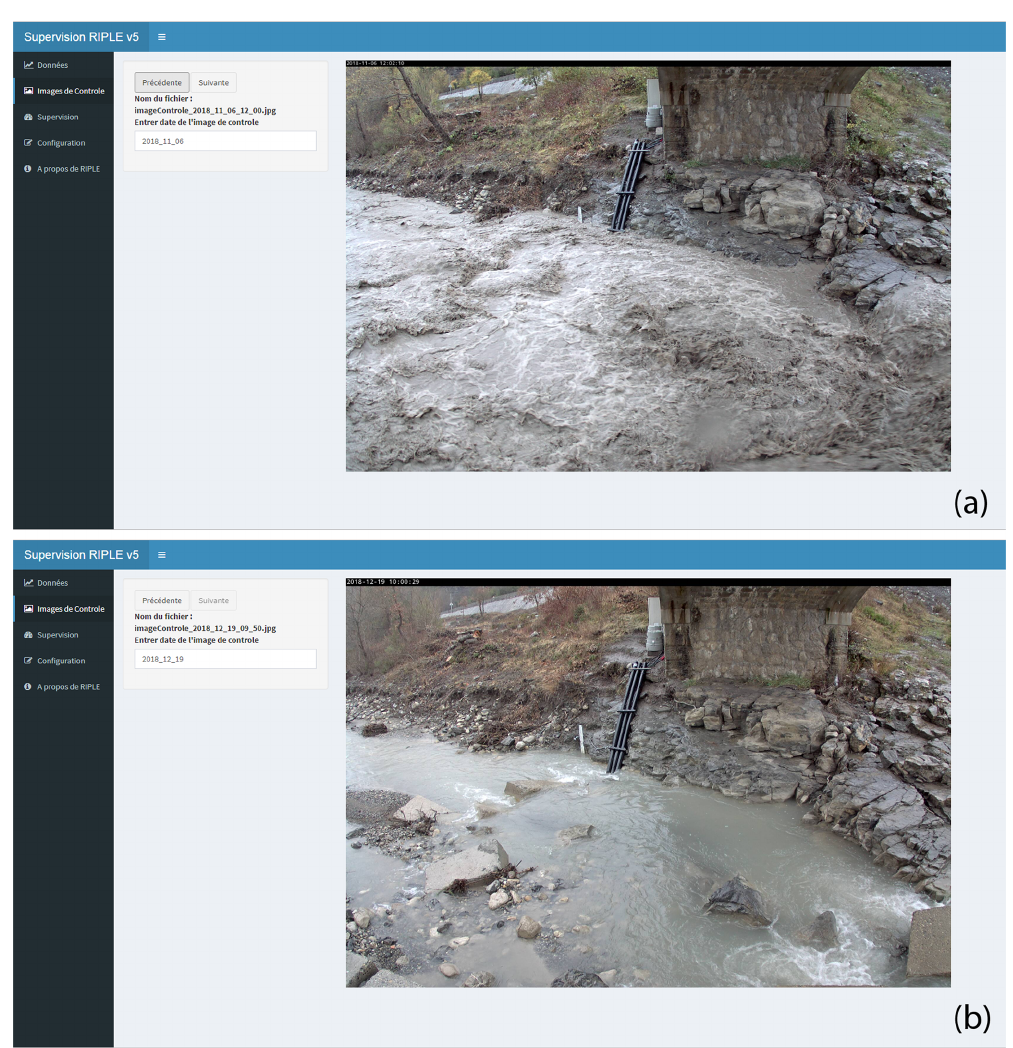
Figure 10. Screenshots of the “Images of control” menu of the user interface at two dates: (a) 6 November 2018 12:00UTC during a flood and (b) 19 December 2018 10:00UTC for low-water conditions.